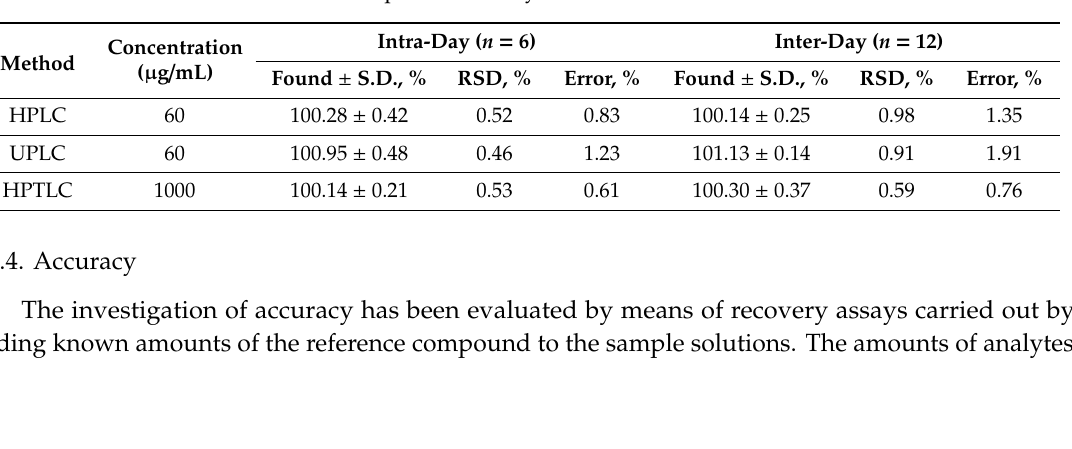
Table 3. Results of precision study for HPLC and UPLC